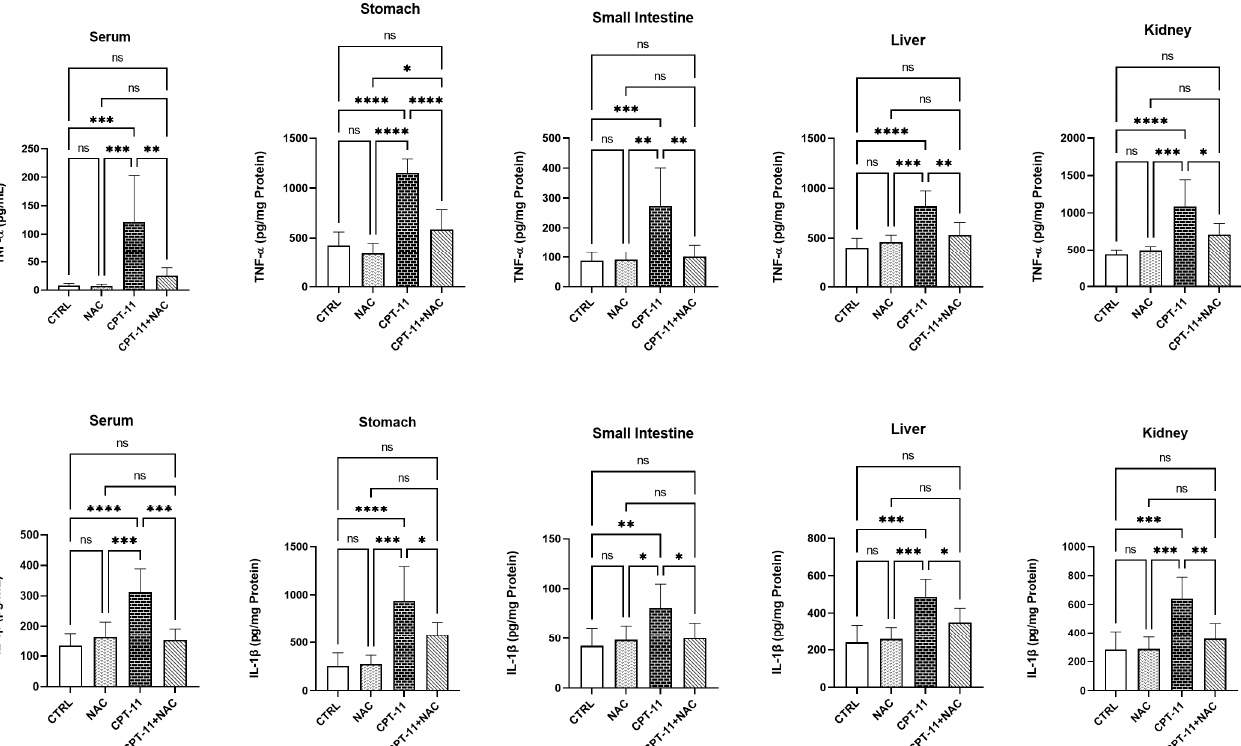
Figure 2. Serum, stomach, small intestine, liver and kidney levels of IL-1 β and TNF- α in experimental groups. * p < 0.05, ** p < 0.01, *** p < 0.001 **** p < 0.0001, ns: non-significant.